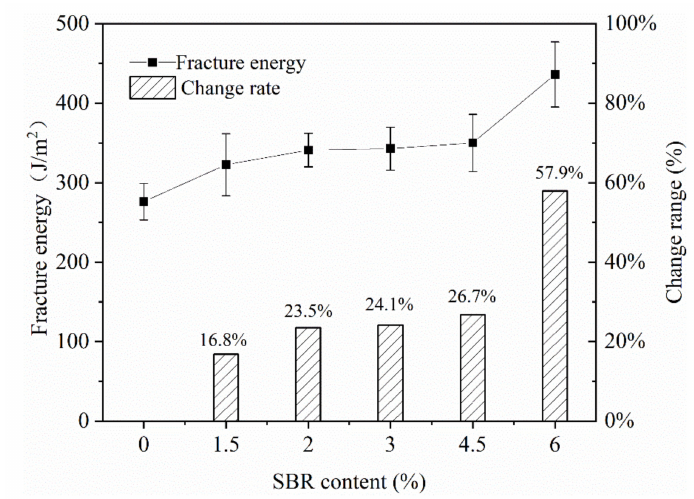
Figure 6. The e ff ect of SBR latex on the fracture energy of the mixture.